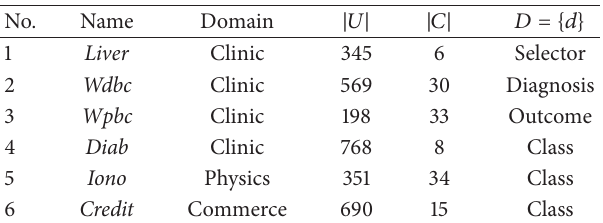
Table 11: Database information. Table 12: Generated neighborhood boundaries for different